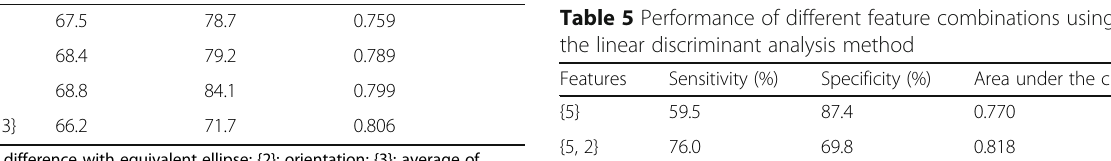
Table 3 Performance of different feature combinations using the multilayer perceptron method Features